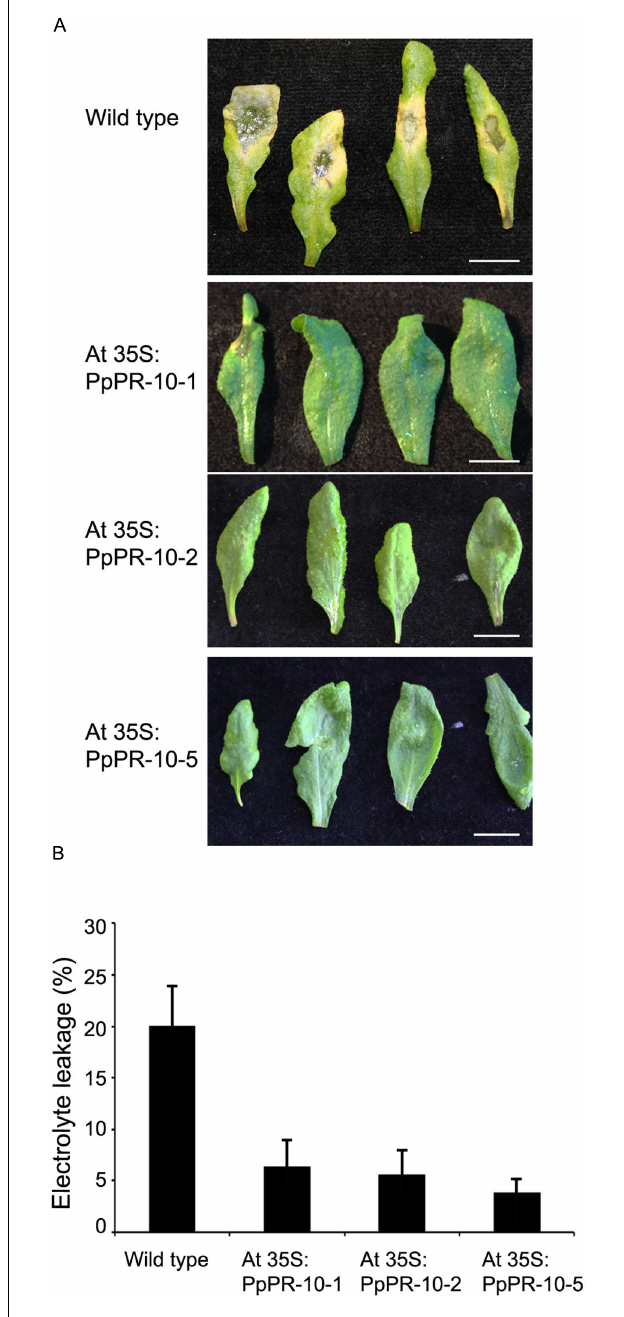
FIGURE 8 | Symptom development and ion leakage measurements in wild type and Arabidopsis PpPR-10 overexpressing lines. (A) Symptom development in wild type, At 35S:PR-10-1, At 35S:PR-10-2, and At 35S:PR-10-5 leaves. (B) Electrolyte leakage in wild type and overexpressing PpPR-10 Arabidopsis